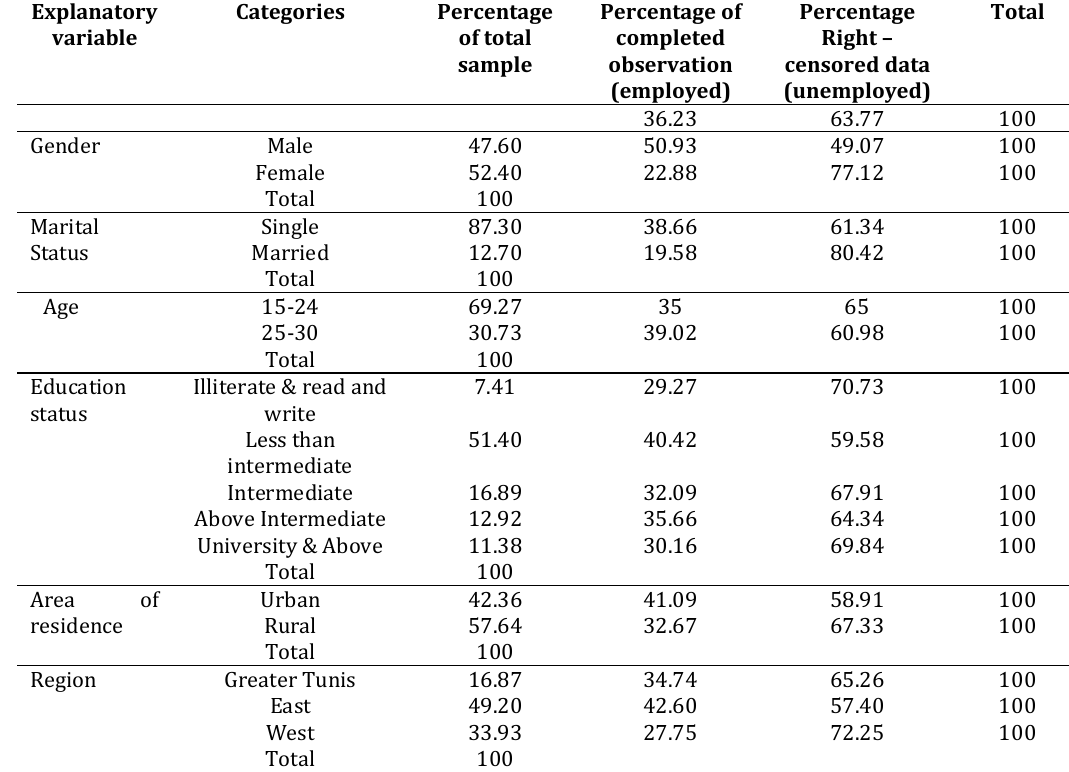
Table 2: Different categories of chosen explanatory variables